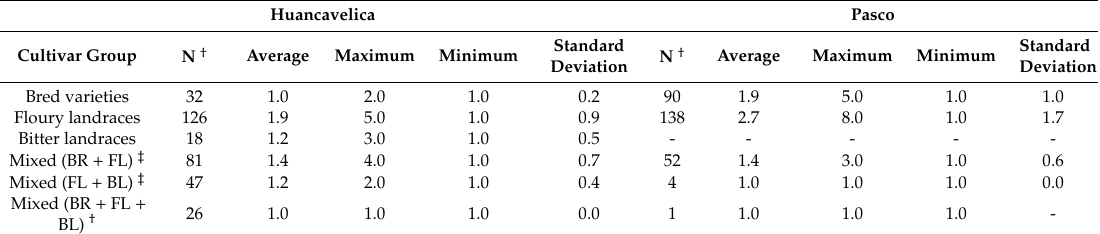
Table 8. Average number of fields per household for exclusive and mixed fields by cultivar group and